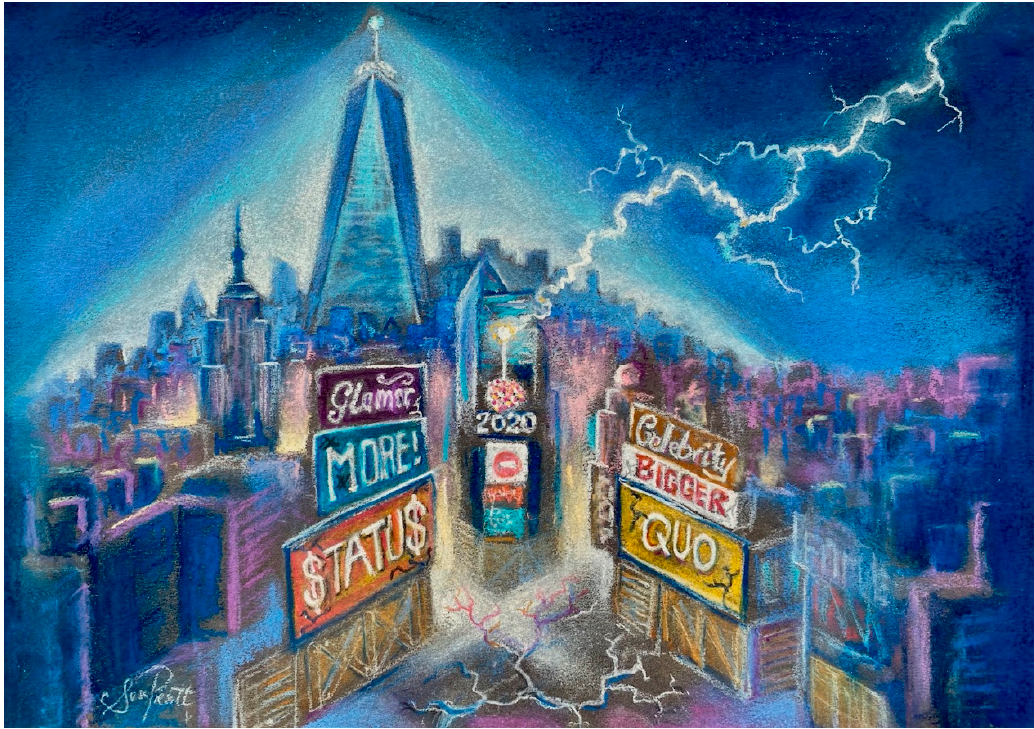
Figure 1. A year to remember: 2020 has been a year of numerous seismic events, spanning from the COVID-19 pandemic, global protests against racial injustice, crisis-level spread of dis/misinformation, the rise of political authoritarianism, catastrophic environmental events, growing disparities in health and life expectancy, and massive wealth accumulation among the privileged as food and housing insecurity increased further among the disadvantaged. (Artwork by S.L.P.).